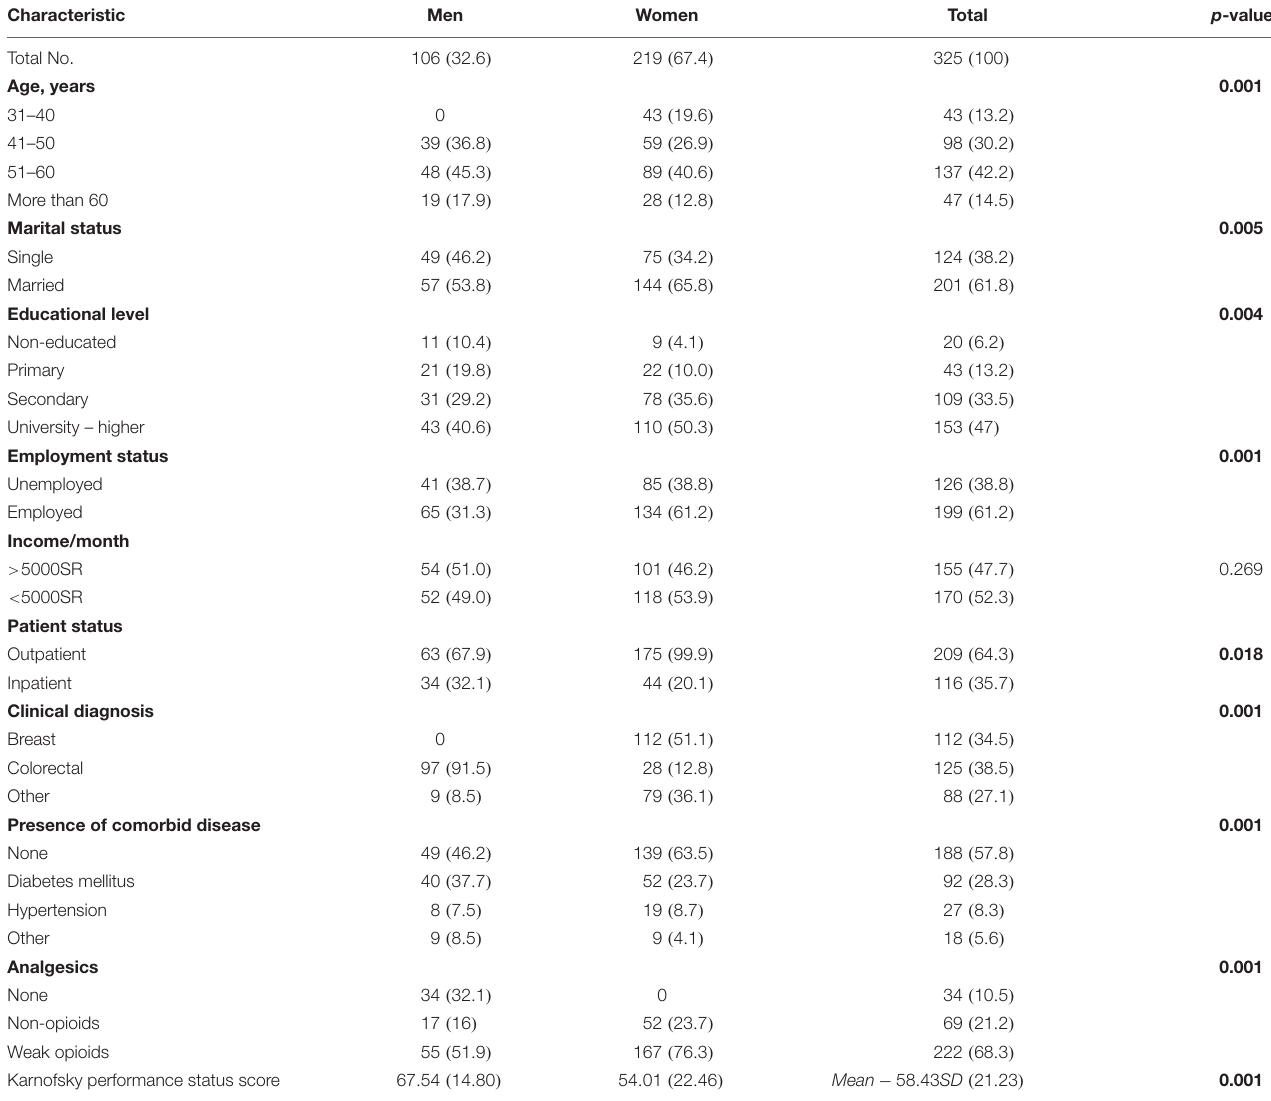
TABLE 1 | Patient demographic